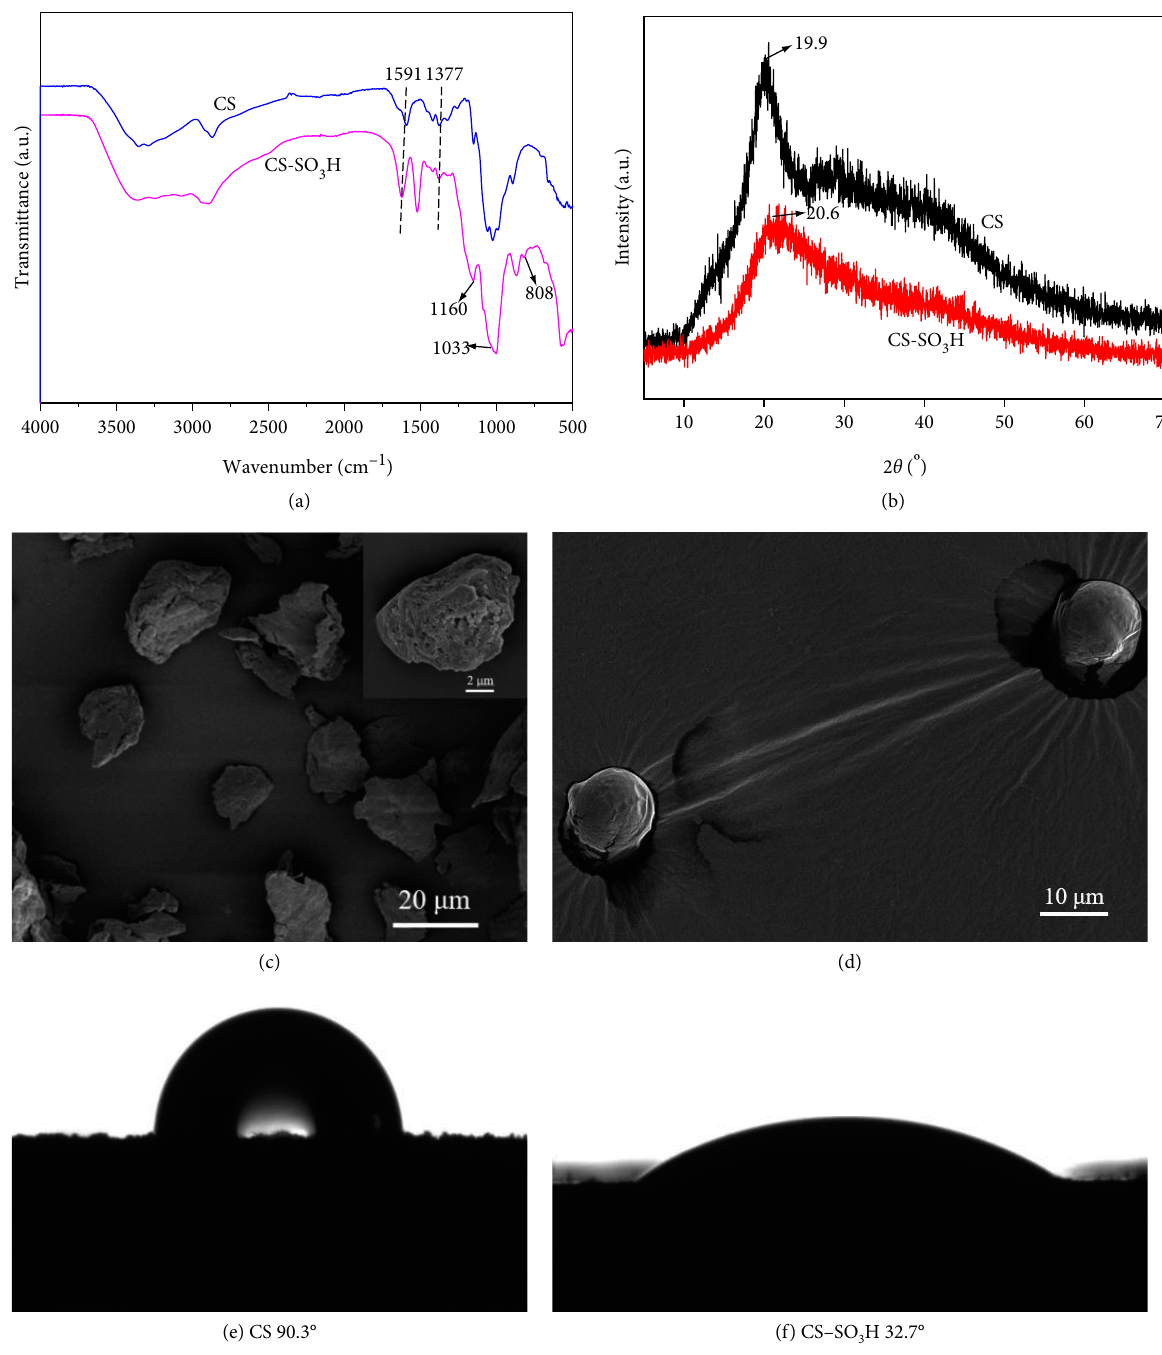
Figure 1: The CS and CS-SO H FT-IR spectra (a), XRD (b), SEM (c) and (d), water contact angle (e) and 3